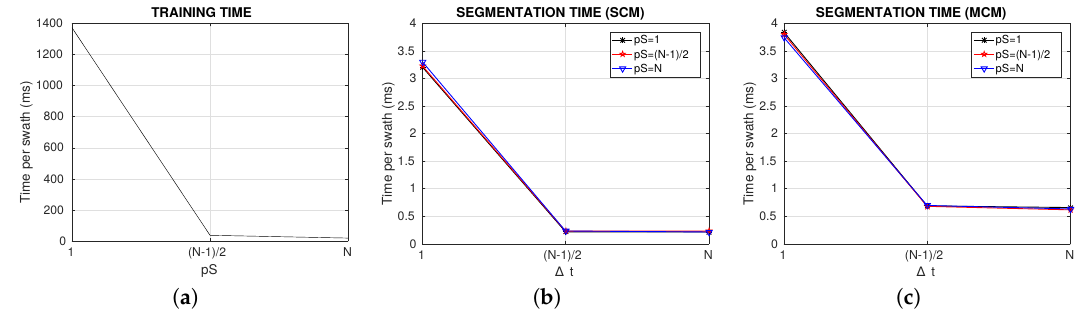
Figure 14. Execution times for ( a ) training, ( b ) segmenting using SCM and ( c ) segmenting using